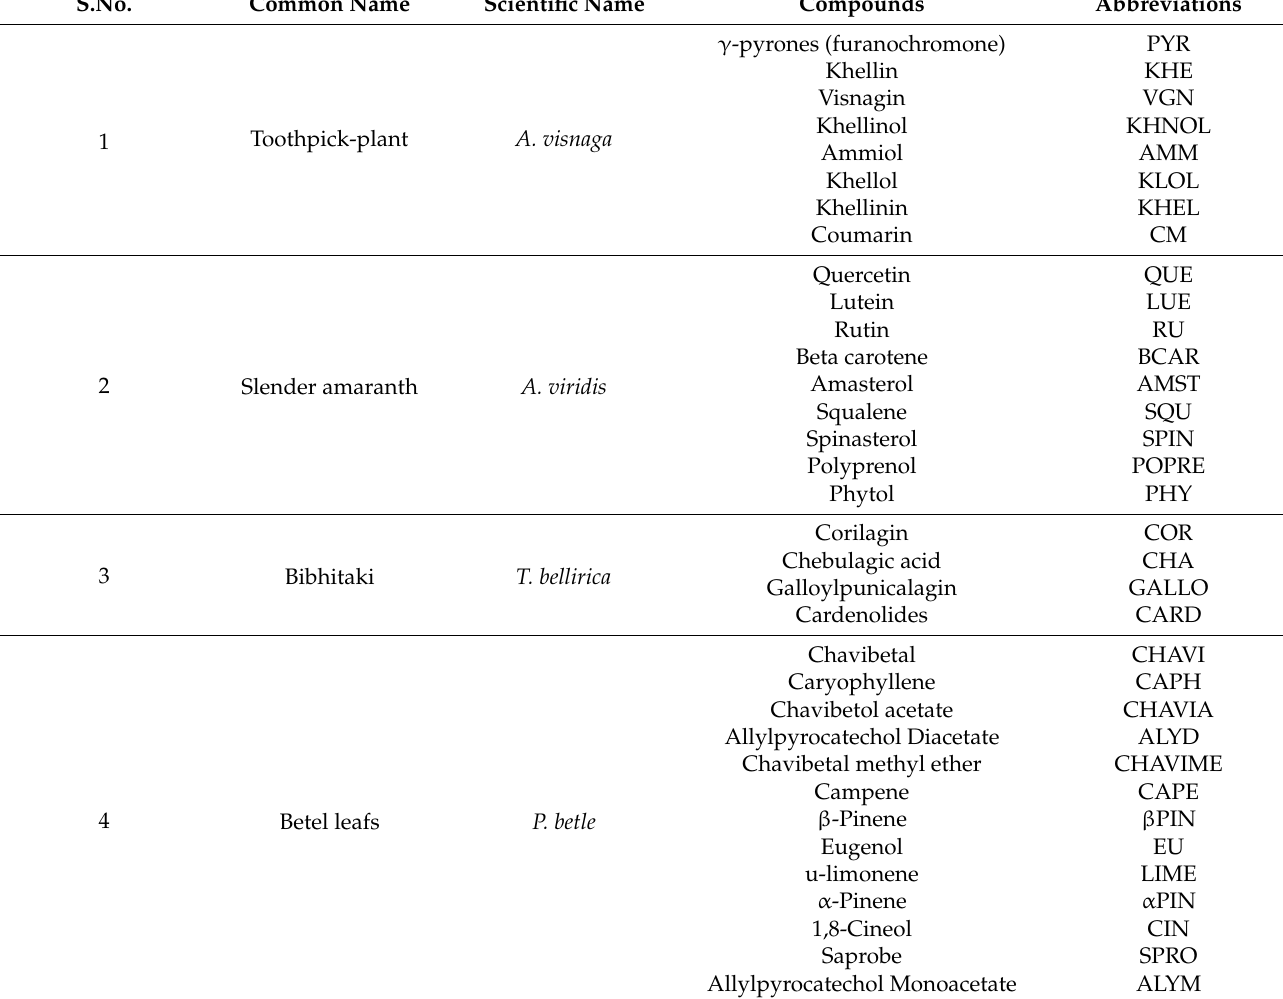
Table 1. List of phytocompounds with their abbreviations.